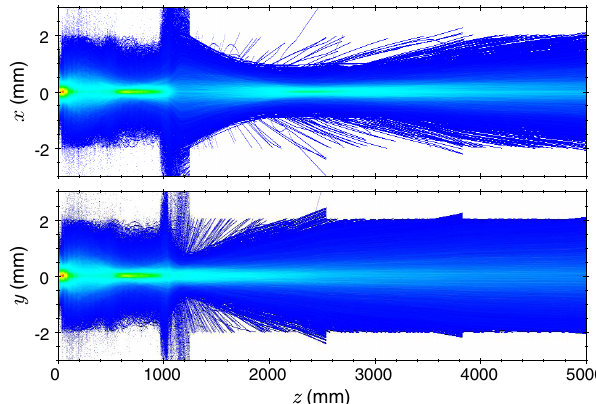
FIG. 11. Beam size in (upper) xz - and (lower) yz